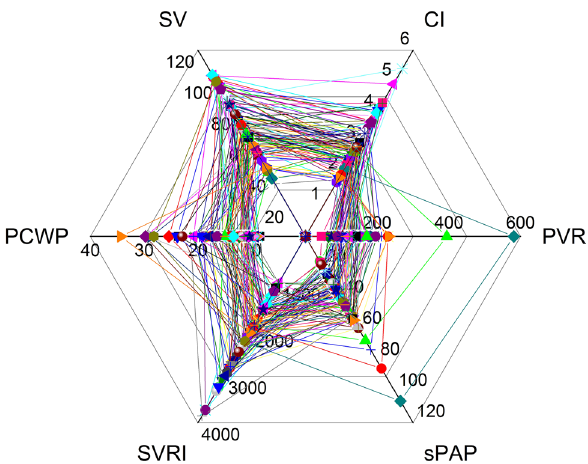
Figure 2. Combined hemodynamic profiles. Hemodynamic profiles of all 107 ICU patients on day three of their intensive care stay as determined by non-invasive hemodynamic critical care echocardiography. Although mean arterial pressure (MAP) was above 60 mmHg in 96.1% of patients, hemodynamic profiling revealed hemodynamic states that induced severe cardiac stress or implied acute cardiac decompensation. CI: cardiac index [L·min −1 ·m −2 ]; SV: stroke volume [mL]; PCWP: pulmonary capillary wedge pressure [mmHg]; SVRI: